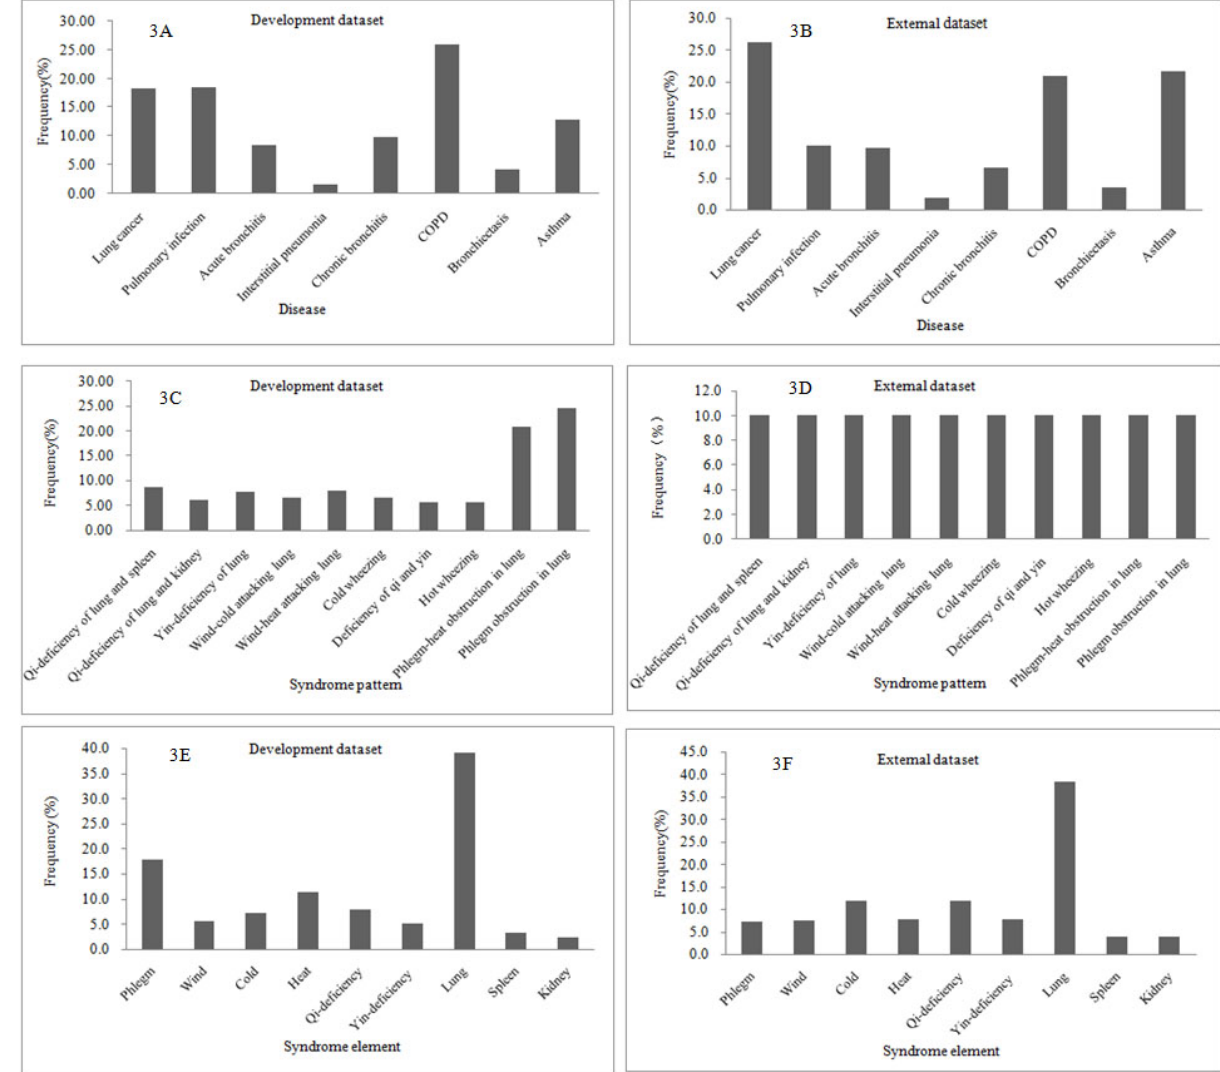
Figure 3. The characteristics of the data set. COPD: chronic obstructive pulmonary